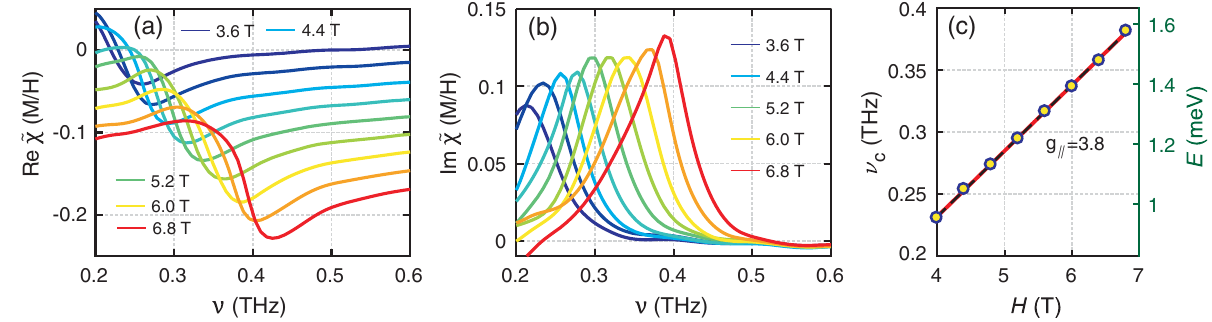
k c dc k c . Yellow dc